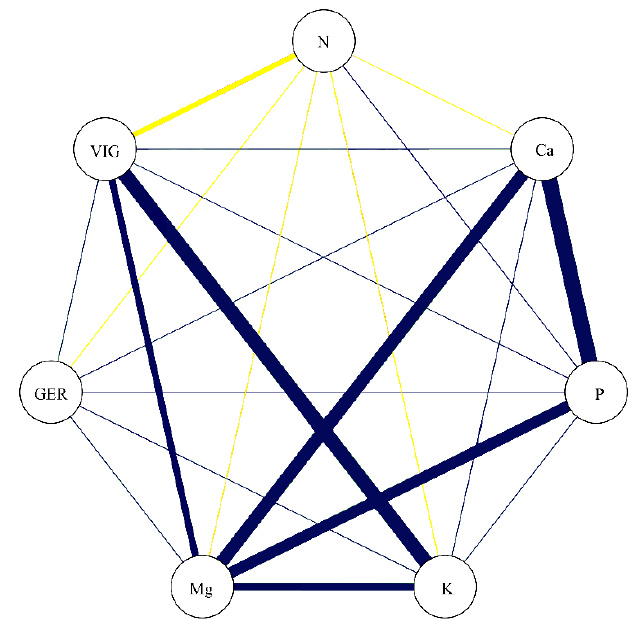
Figure 7. Correlation network among germination (GER), vigor (VIG), nitrogen (N), calcium (Ca), phosphorus(P),potassium(K),andmagnesium(Mg). Bluelinesindicatepositivecorrelation, andyellow lines indicate negative correlation. Line thickness demonstrates the degree of association between the